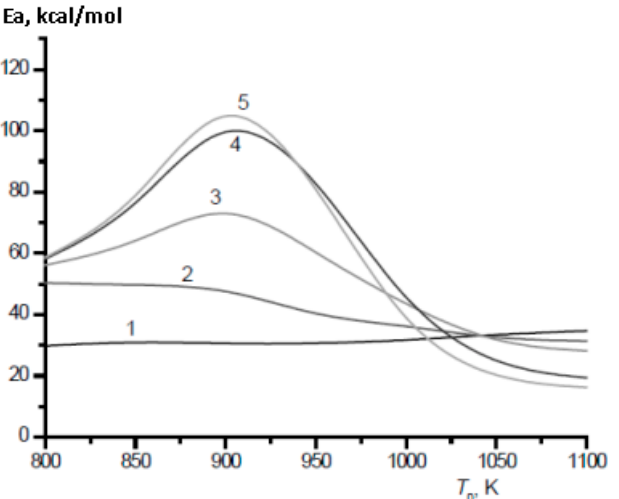
Figure 12. Calculated temperature dependence of the effective activation energy of the ignition delay time for stoichiometric mixtures CH 4 –H 2 –air (Ea, kcal/mol) on the initial temperature T 0 at various values of the H 2 concentration (%): 0 (1), 40 (2), 70 (3), 90 (4), 100 (5). P 0 = 1 bar (Adapted with permission from ref. [30], Copyright 2018, OBRACADEMNAUKA.).